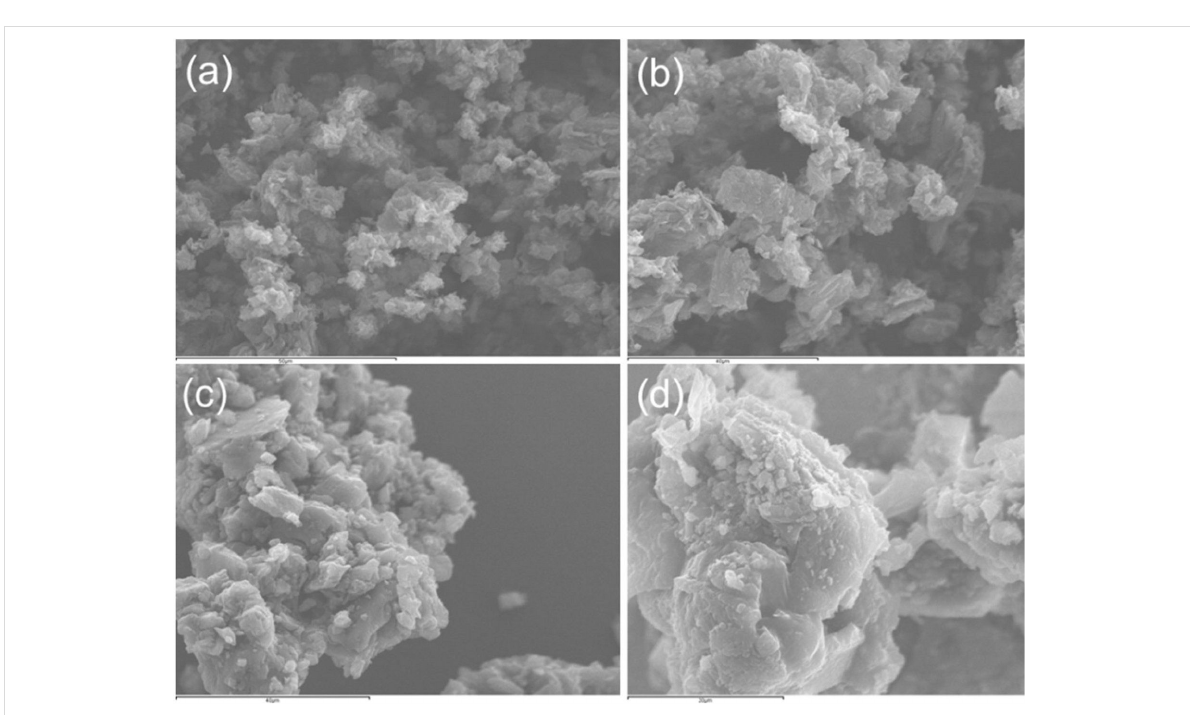
Figure 1: N 2 isotherms of (a) RGO, (b) Fe/RGO, and (c) Co/RGO.